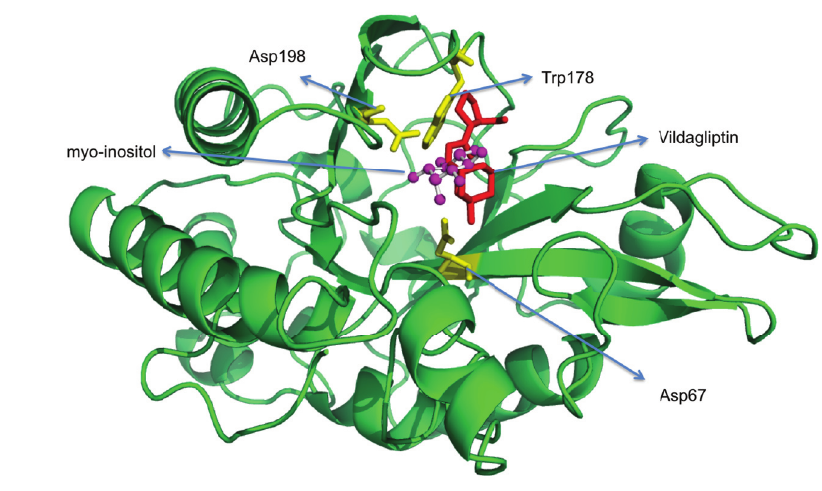
Figure 4. Docking vildagliptin to the PI-PLC structure in complex with myo-inositol (PDBid:1PTGA). Docking done using DOCLASP 40 . The Pymol script for visualizing the docking (SupplementaryPymol.p1m) is provided as Supplementary information. ligand-DPP4 structure is solved (Supplementary Table 2). For uni-